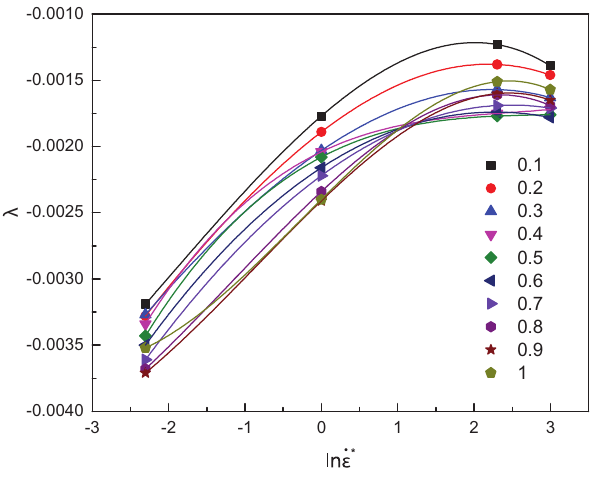
Figure 9: Relationship between λ and ln _ ε *